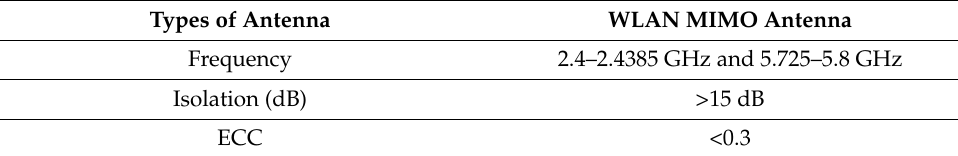
Table 1. Some performance requirements of the antenna.